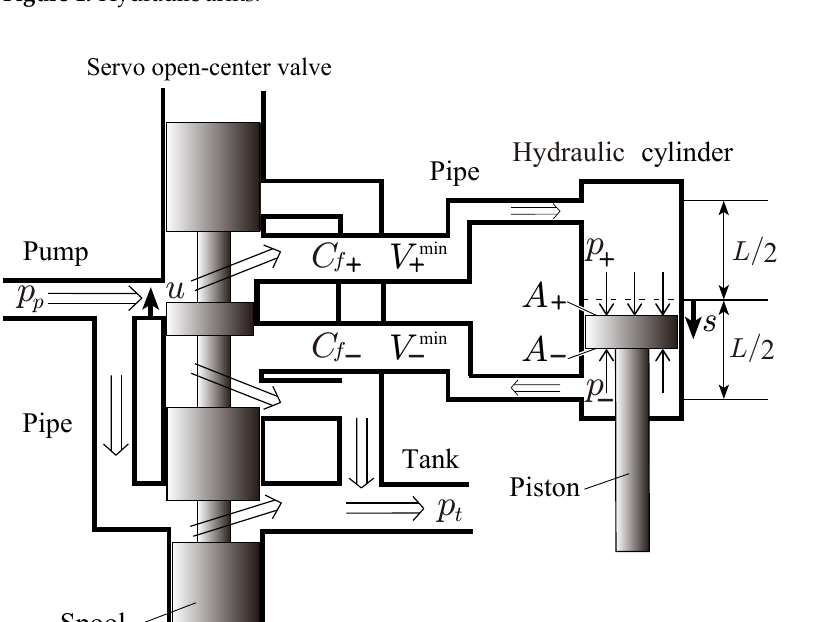
Figure 1. Hydraulic arms.